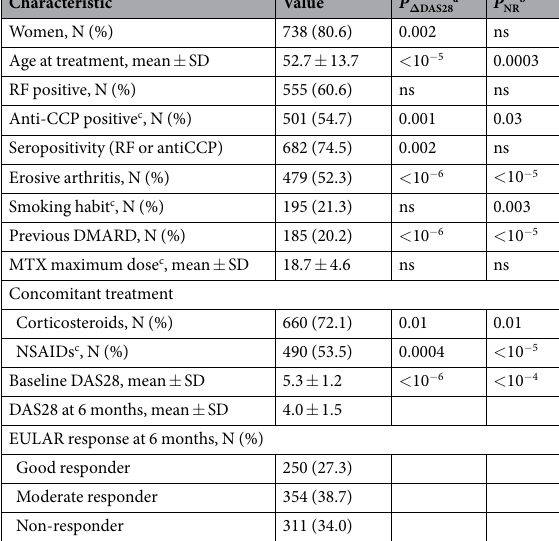
Table 1. Characteristics of the 915 patients with RA and their association with response to MTX. a Response to MTX assessed as Δ DAS28 and analyzed with linear regression. b Response to MTX assessed as EULAR non- response (NR) and analyzed with logistic regression. c Data from < 85% of the patients were